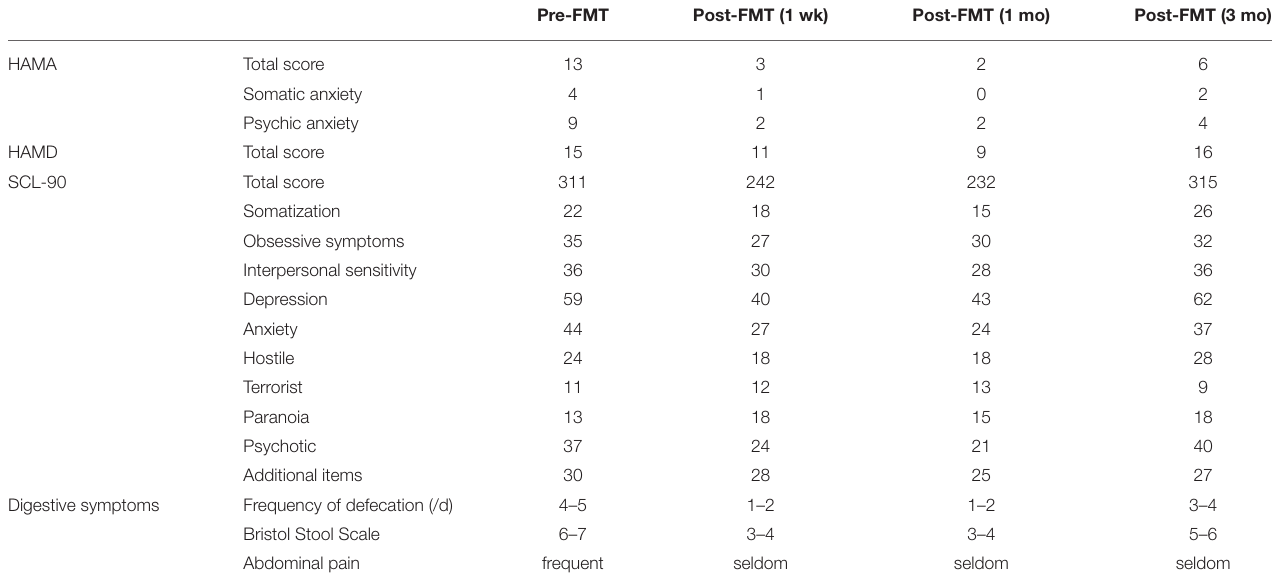
TABLE 1 | Follow up of patient’s psychological and digestive